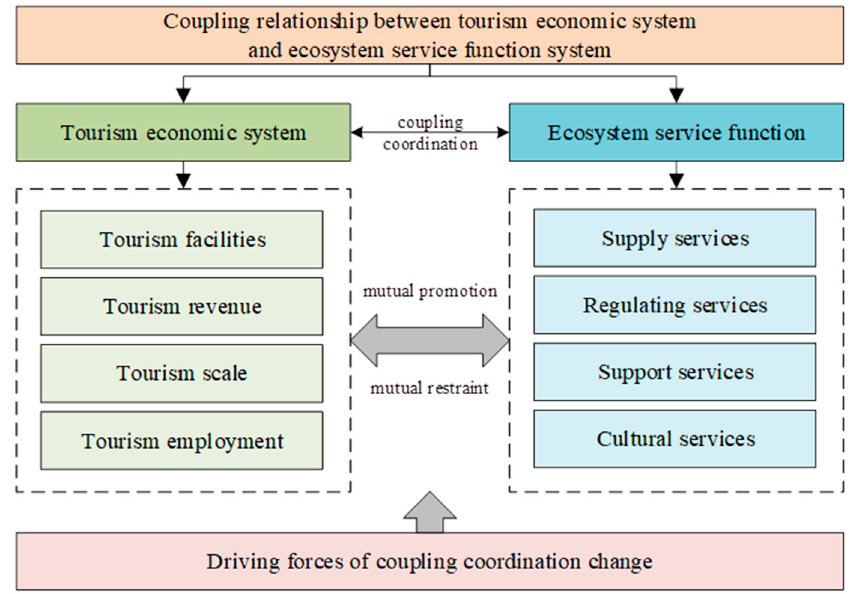
Figure 1. Coupling relationship between a tourism economic system and ecosystem service function system.